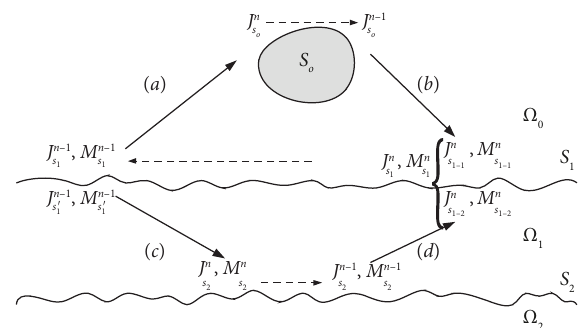
Figure 2: Te mutual coupling strategy among the